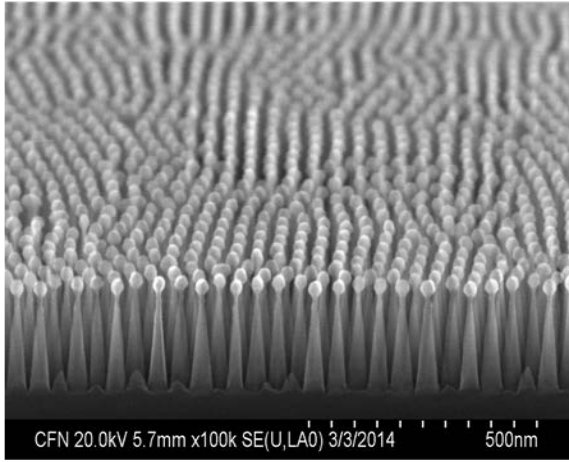
Figure 1. The nanoscopic structure of a moth’s eye [65]. The surface of the Moth’s eye structure results in broadband anti-reflection e ff ects, due to its nature of refractive indices changes between the